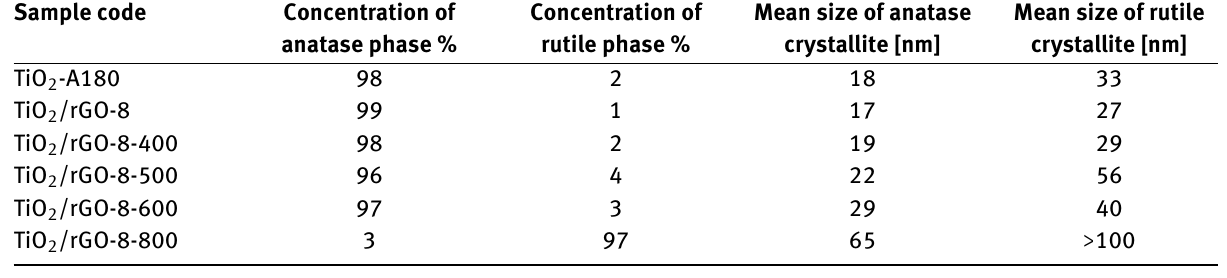
Table 1: XRD phase composition and mean crystallites size of reference, control and obtained photocatalysts